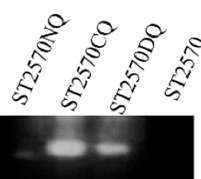
Figure 2. Selective labelling of aldehyde tagged proteins with Alexa Fluor 647 C5-aminooxyacetamide.